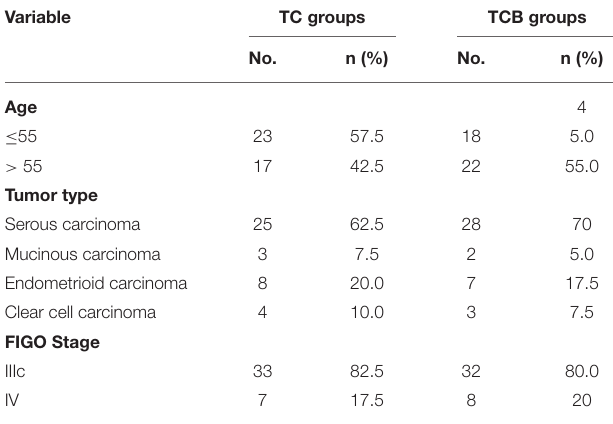
TABLE 1 | Demographic and clinical features of ovarian cancer